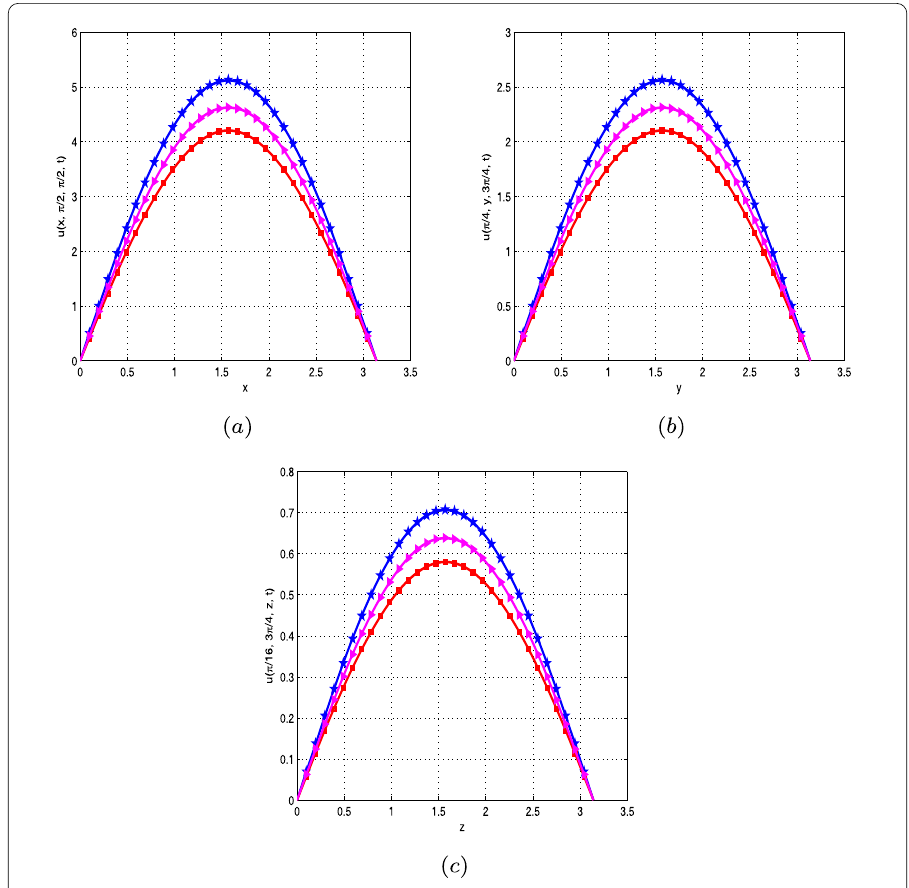
Figure 2 Exact solutions (lines) and numerical solutions (symbols) at t = 0.1 (red), t = 0.3 (magenta) and t = 0.5 (blue) by using scheme (59)–(61) (Example